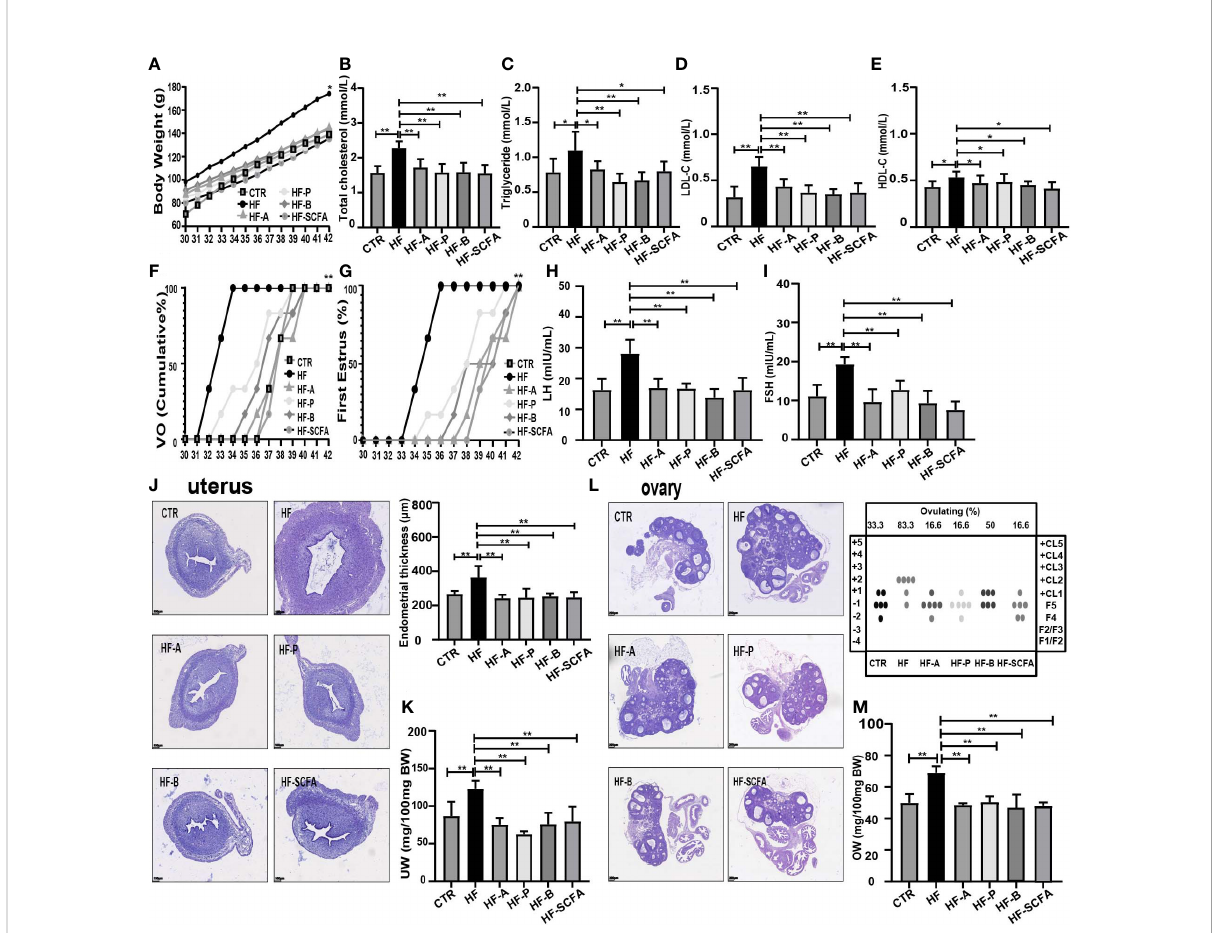
FIGURE 5 SCFAs reverse obesity and precocious puberty in obesity-induced precocious puberty rats. (A) Evolution of body weight. (B) Serum total cholesterol. (C) Serum triglyceride. (D) Serum low density lipoprotein cholesterol (LDL-C). (E) Serum high density lipoprotein cholesterol (HDL-C). (F) Cumulative percentage of vaginal opening. (G) Cumulative percentage of fi rst estrus. (H) Serum LH levels. (I) Serum FSH levels. (J) Morphological and histopathological changes in uterine and uterine wall thickness after addition of SCFAs. (K) Relative uterus weight. (L) Histological score of follicular development and ovulation after addition of SCFAs diet. (M) Relative ovary weight. n = 6 per group for rat samples. * P <0.05; ** P